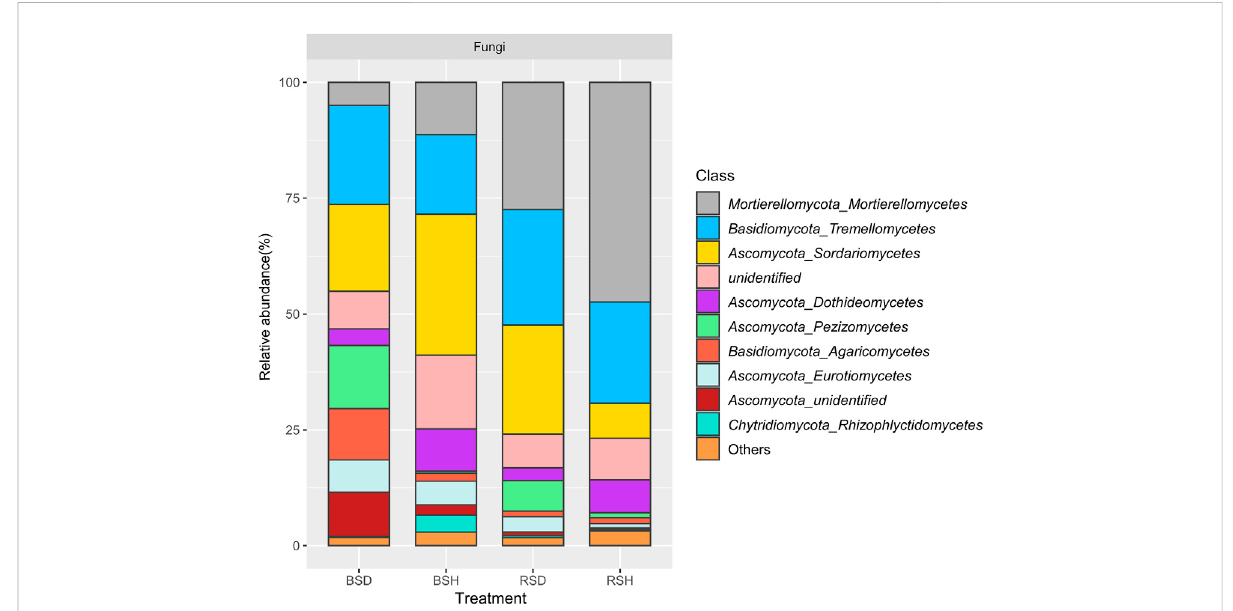
FIGURE 3 Relativeabundanceof10dominantclassesinfungiamongthebulksoilofthediseasedplant,thebulksoilofhealthyplants,therhizospheresoil of disease plantsand therhizosphere soil of healthy plants. Family accounting for less than 1% of total reads were classi fi ed as “ others ” . BSD, thebulk soil of the diseased plant; BSH, the bulk soil of healthy plants; RSD, the rhizosphere soil of disease plants; RSH, the rhizosphere soil of healthy plants Signi fi cance satis fi es p < 0.05 based on Tukey